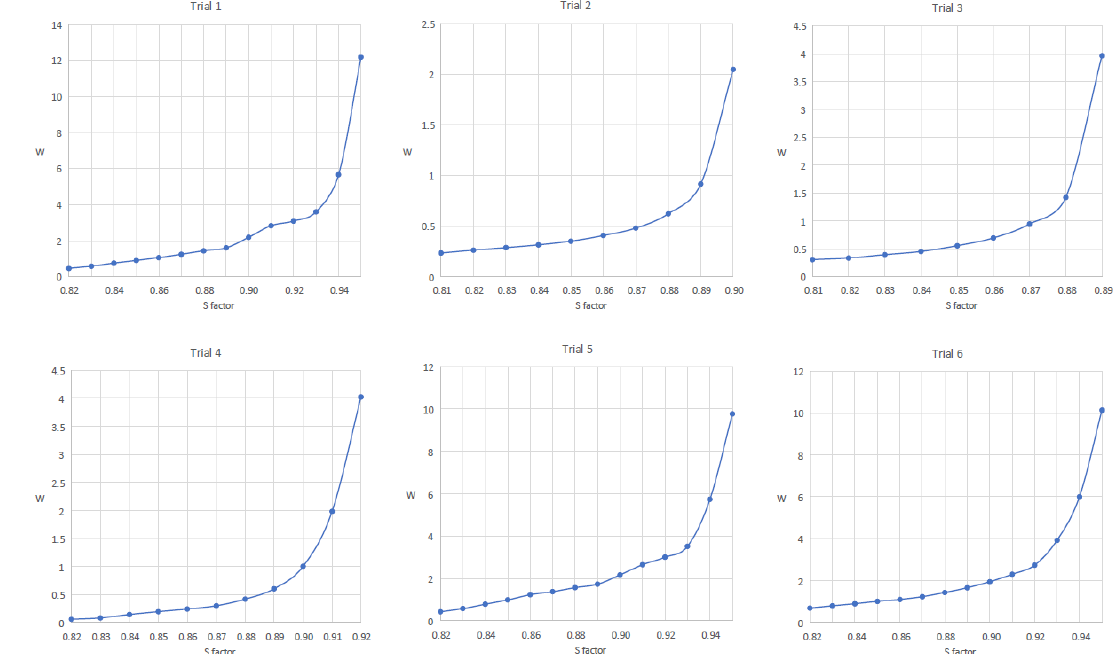
Figure 6. Representation of W as a function of S factor values for the 6 patients.